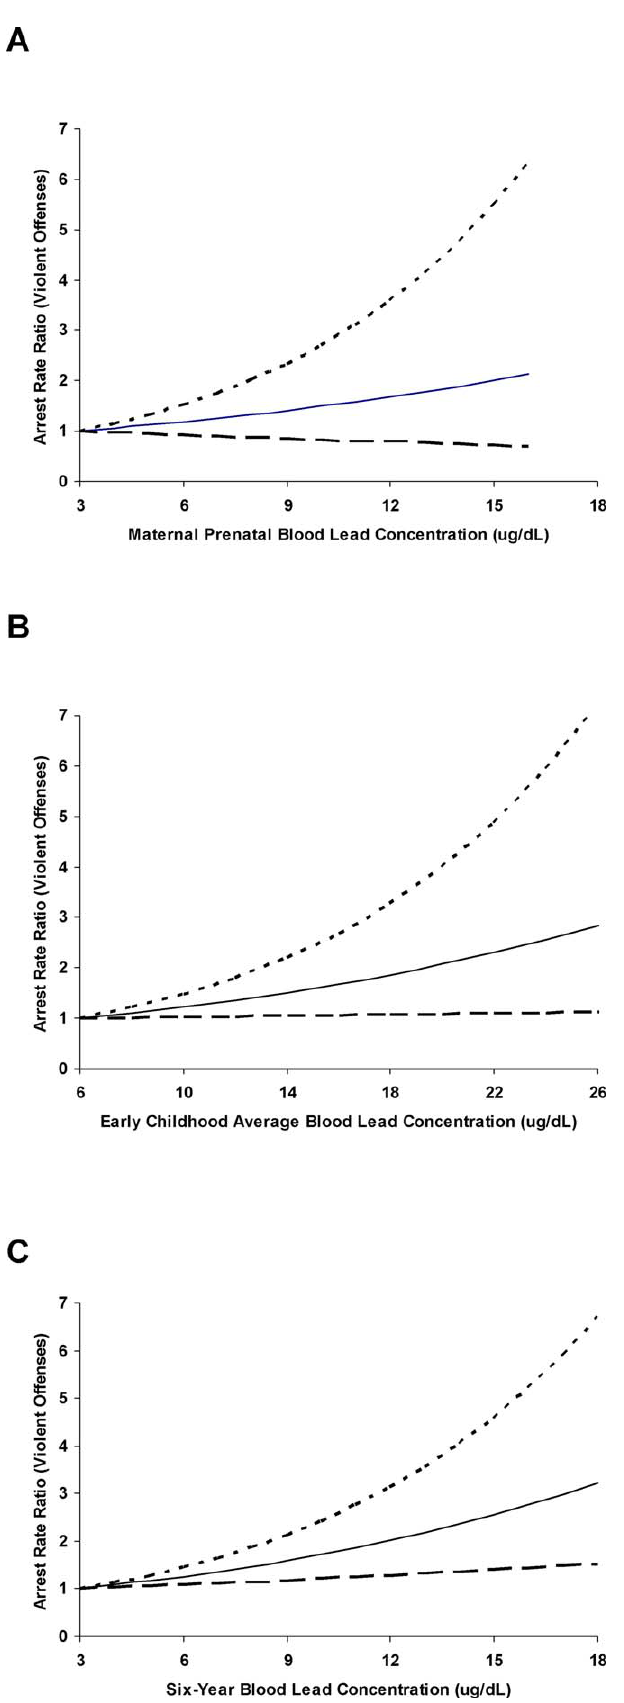
Figure 2. Adjusted Relationship between Blood Lead Concentration and Arrest Rate Ratio For Violent Offenses Shown are data for maternal prenatal blood lead concentration (A), early childhood average blood lead concentration (B), and 6-year blood lead concentration (C). Rate ratios are plotted as a function of increasing blood lead from the 5th to the 95th percentiles of blood lead relative to participants at the 5th percentile. Dashed lines are 95% confidence intervals. To convert to l mol/l: ( l g/dl) 3 0.04826.